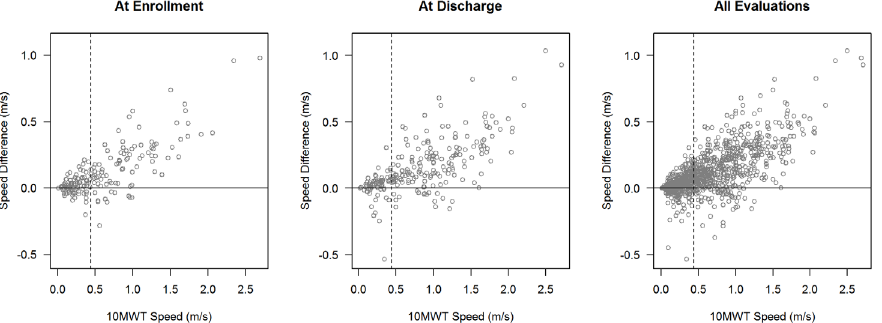
Figure 2. Difference in walk speeds (10MWT 2 6MWT) by speed on 10MWT for enrollment, discharge, and all evaluations. Vertical dashed line is at 0.44 m/s, separating slow and fast walkers. Negative values represent faster gait speeds on the 6MWT than the